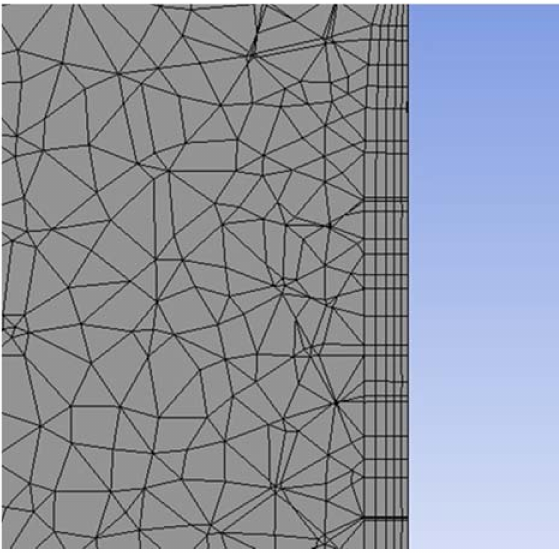
Figure 3. Inflation used in the OS and OW models. Table 1. The initial parameters for the